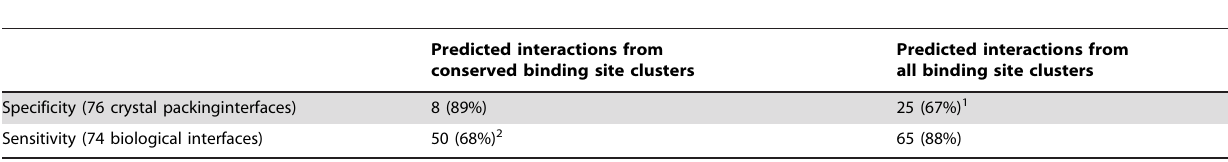
Predicted interactions from conserved binding site